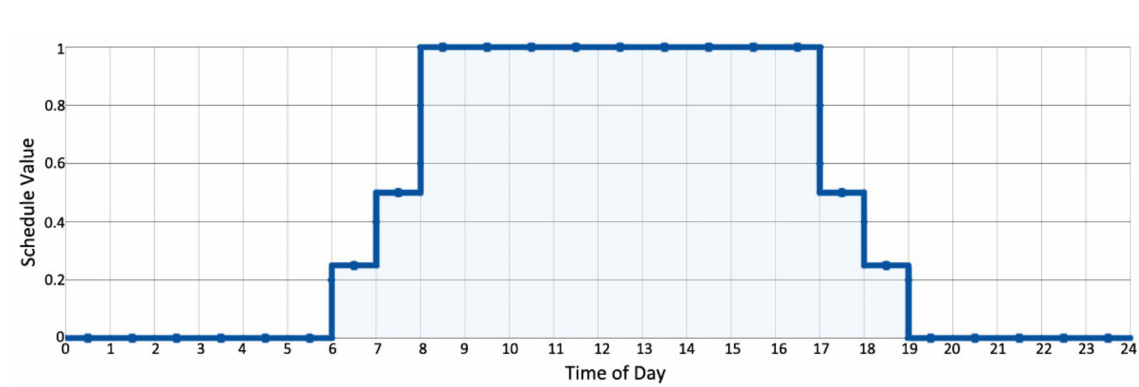
Figure A1. Space Occupations